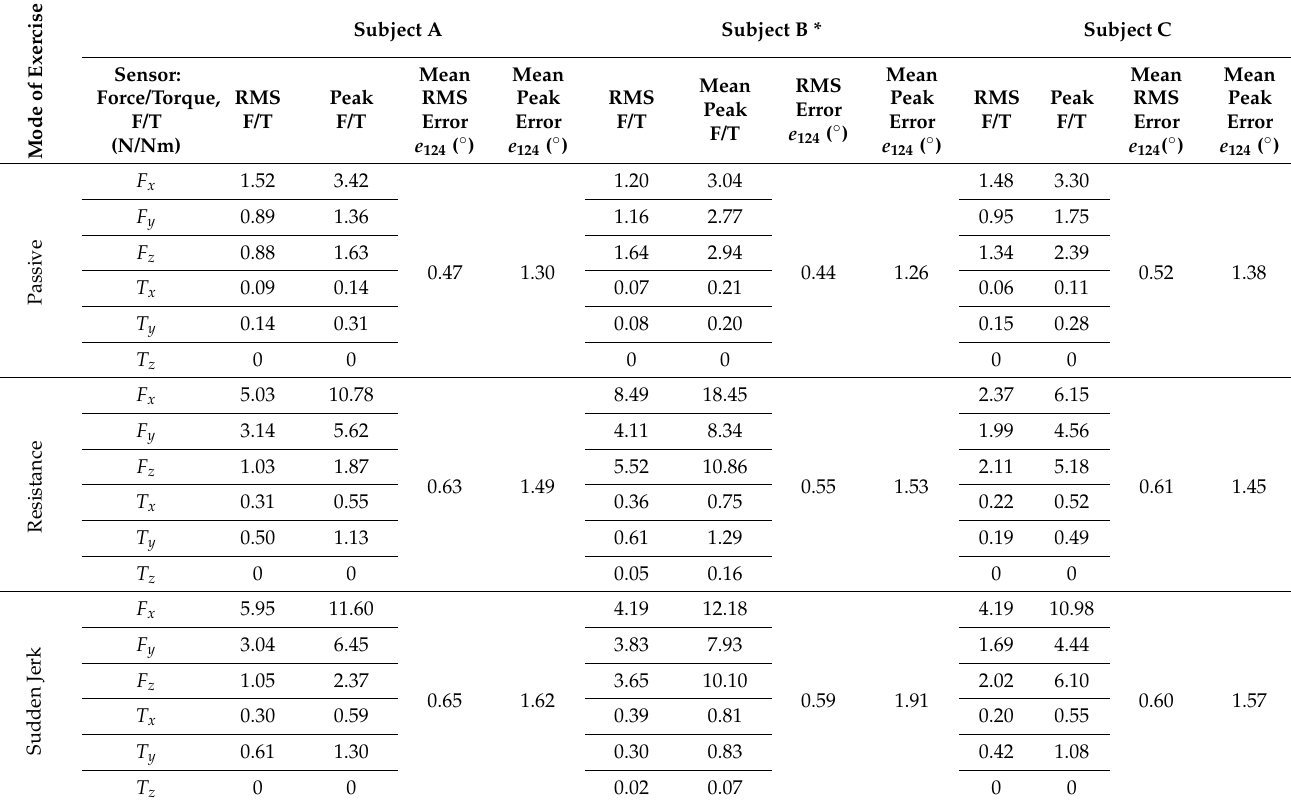
Table 7. Diagonal reaching passive exercise (composite motion of Joints 1, 2, and